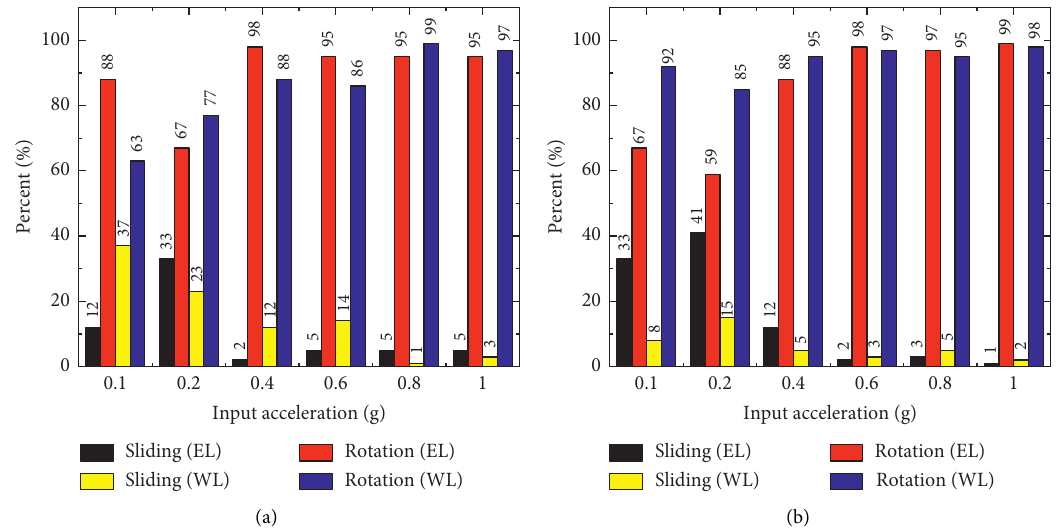
Figure 13: Sliding percentage and rotation percentage: (a) scale factor of 1/4 and (b) scale factor of